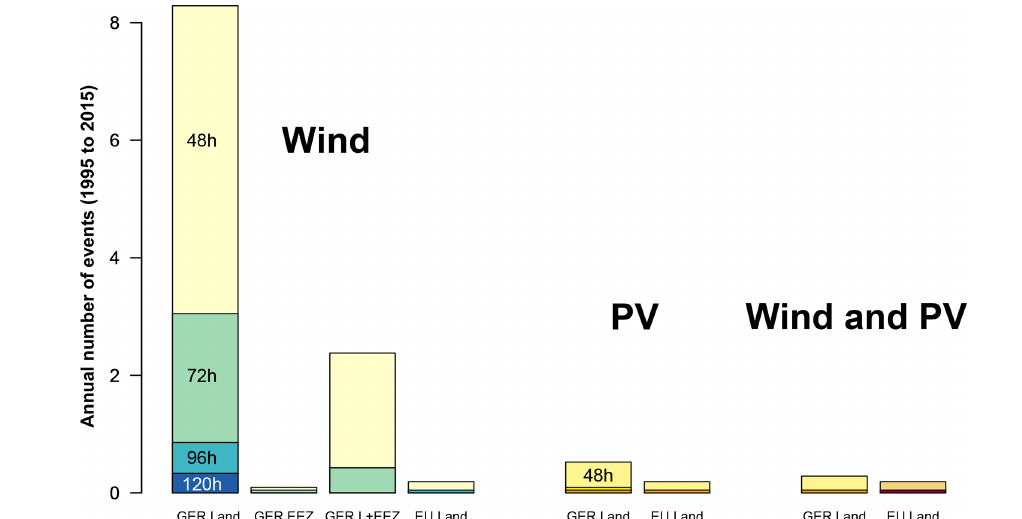
Figure A1. Average annual number of events within a period of 21 years of data when the capacity factor remained below a threshold value of 5% (otherwise same as Fig. 6).